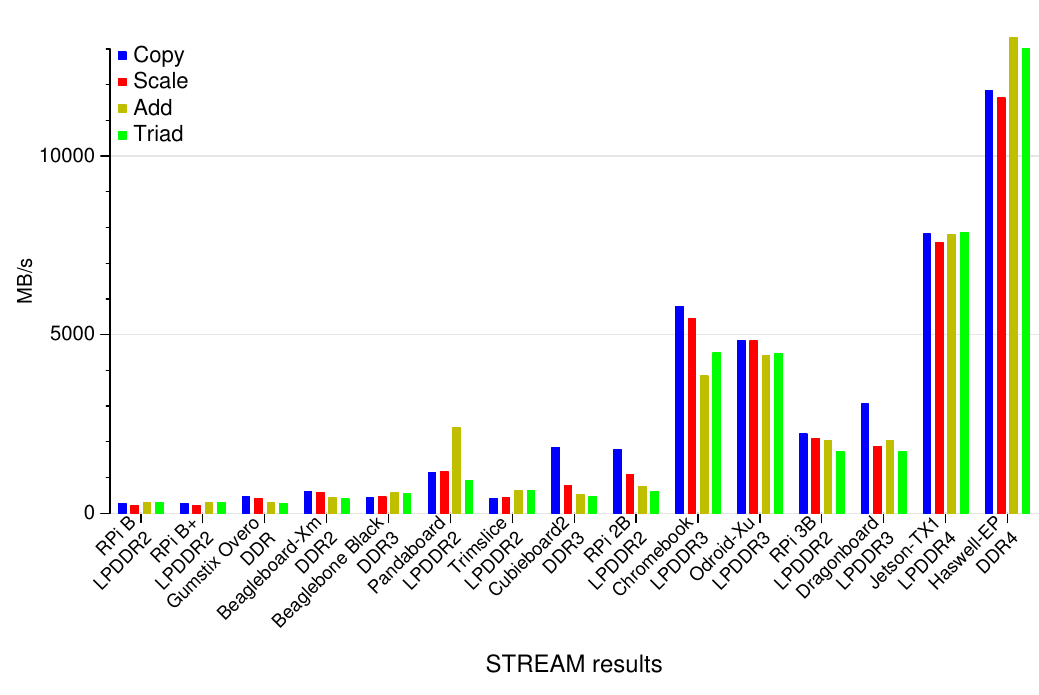
Figure 3. STREAM benchmark